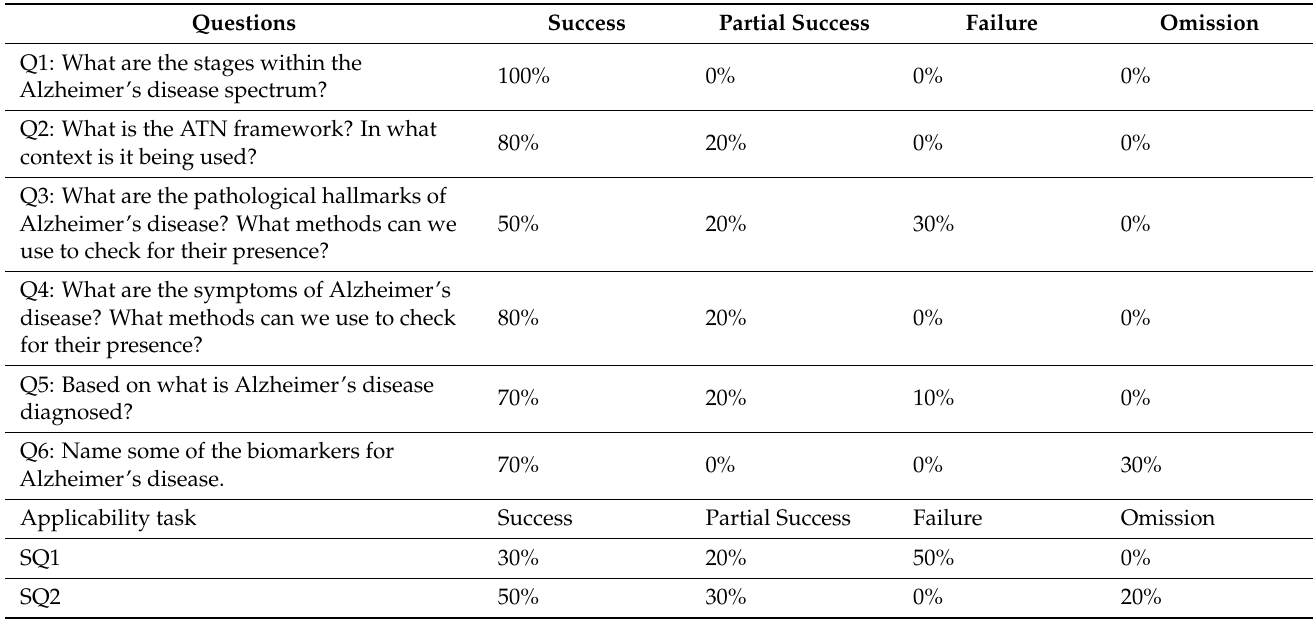
Table 3. Success rates per question estimated for both correctness and applicability tasks. Success refers to the percentage of fully correct answers. Partial success is defined by the percentage of partially correct answers. The percentage of incorrect answers is represented by the ‘Failure’ column and all unanswered questions were regarded as omissions.